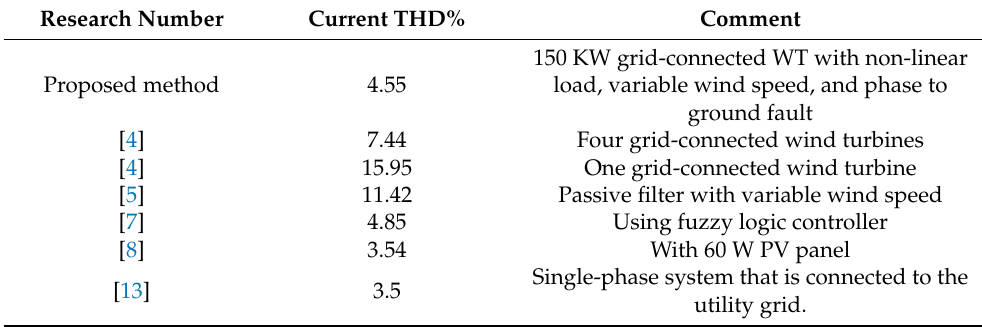
Table 5. Results compression for current THD with other